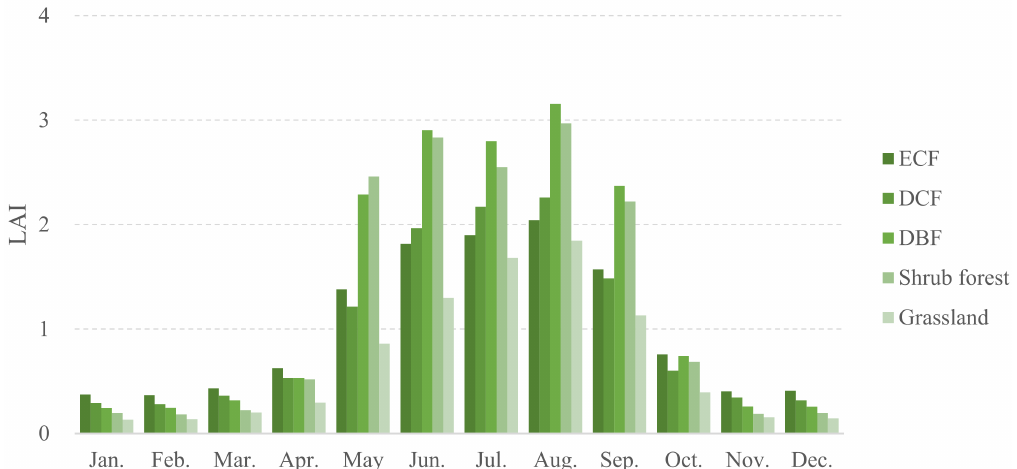
Figure 8. Monthly mean value of LAI of each forest stand from 2015 to